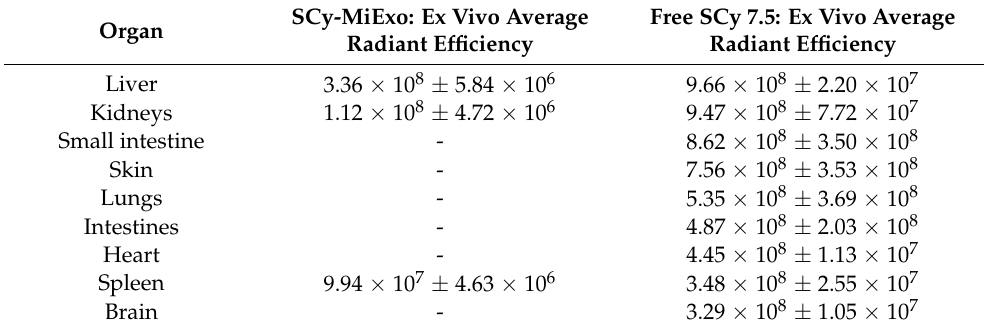
Figure 5. In vivo and ex vivo studies with SCy-MiExo: ( A ) In vivo optical imaging of sulfo-cyanine 7.5-labeled milk exosomes (SCy-MiExo, top) and free SCy 7.5 (bottom) in healthy mice. ( B ) The time course of average radiant efficiency measured in vivo in livers of mice treated with SCy-MiExo. The data are expressed as the % (graph) and in units of p/s/cm 2 /sr)/( µ W/cm 2 ) (table), with the mean ± standard deviation. ( C ) Ex vivo biodistribution of SCy-MiExo (left) and free SCy 7.5 (right) in excised organs. ( D ) Confocal images of liver sections from mice treated with SCy-MiExo. Right down image presents a zoom of left down image. ( E ) Hematoxylin and Eosin (H&E) histological images of liver sections from mice treated with SCy-MiExo. Table 1. Ex vivo average radiant efficiencies (p/s/cm 2 /sr)/( µ W/cm 2 ) of sulfo-cyanine 7.5-labeled are expressed as the mean ± standard